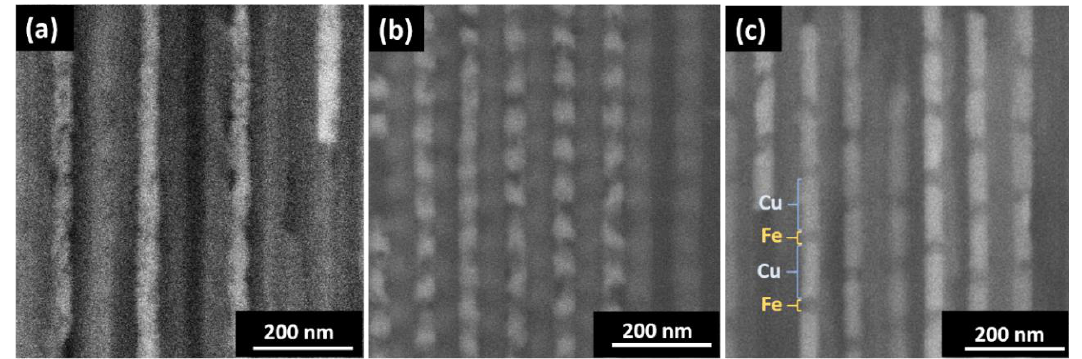
Figure 1. Cross-sectional Scanning Electron Microscopy (SEM) images of Fe/Cu nanowires (NWs) grown in Anodic Aluminum Oxide (AAO) membranes. The average diameter and length of the Fe segments were kept constant to (45 ± 5) nm and (30 ± 7) nm, respectively, while the Cu segment length ( L Cu ) was varied: ( a ) (15 ± 5) nm; ( b ) (60 ± 6) nm; ( c ) (120 ± 10) nm.